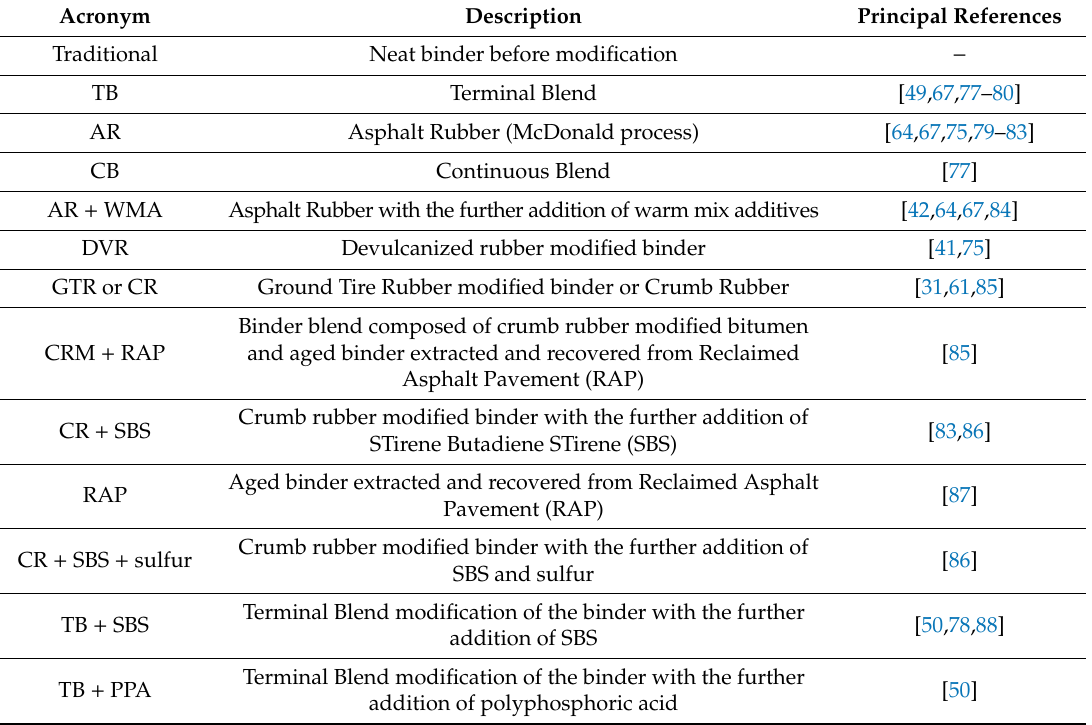
Table 2. Principal acronyms of the modification process and technologies found in the literature that are useful for a better understanding of the